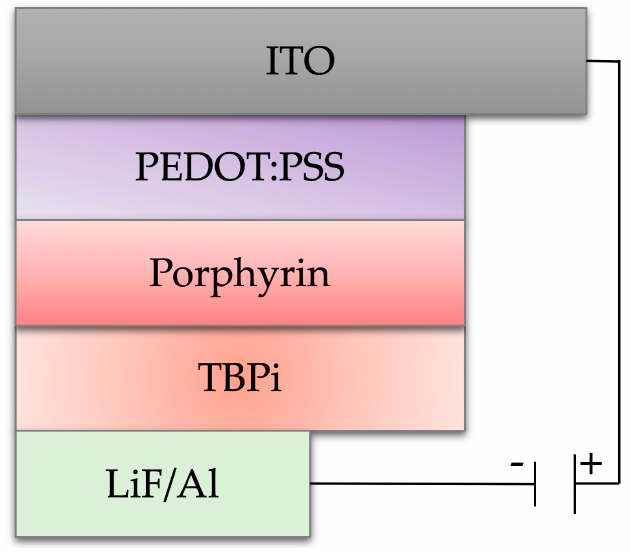
Figure 5. Schematic structure of the OLEDs.